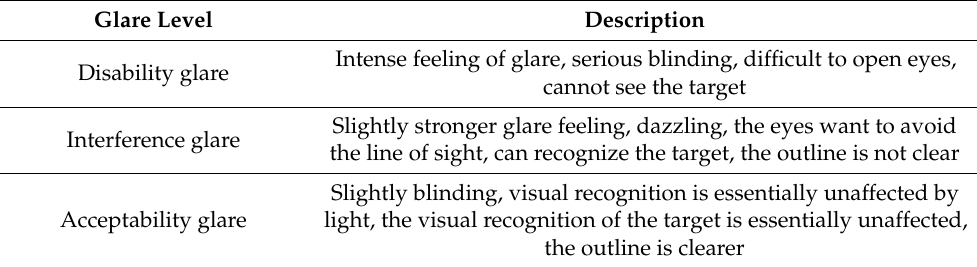
Table 1. Subjective headlight glare scale and relevant description.